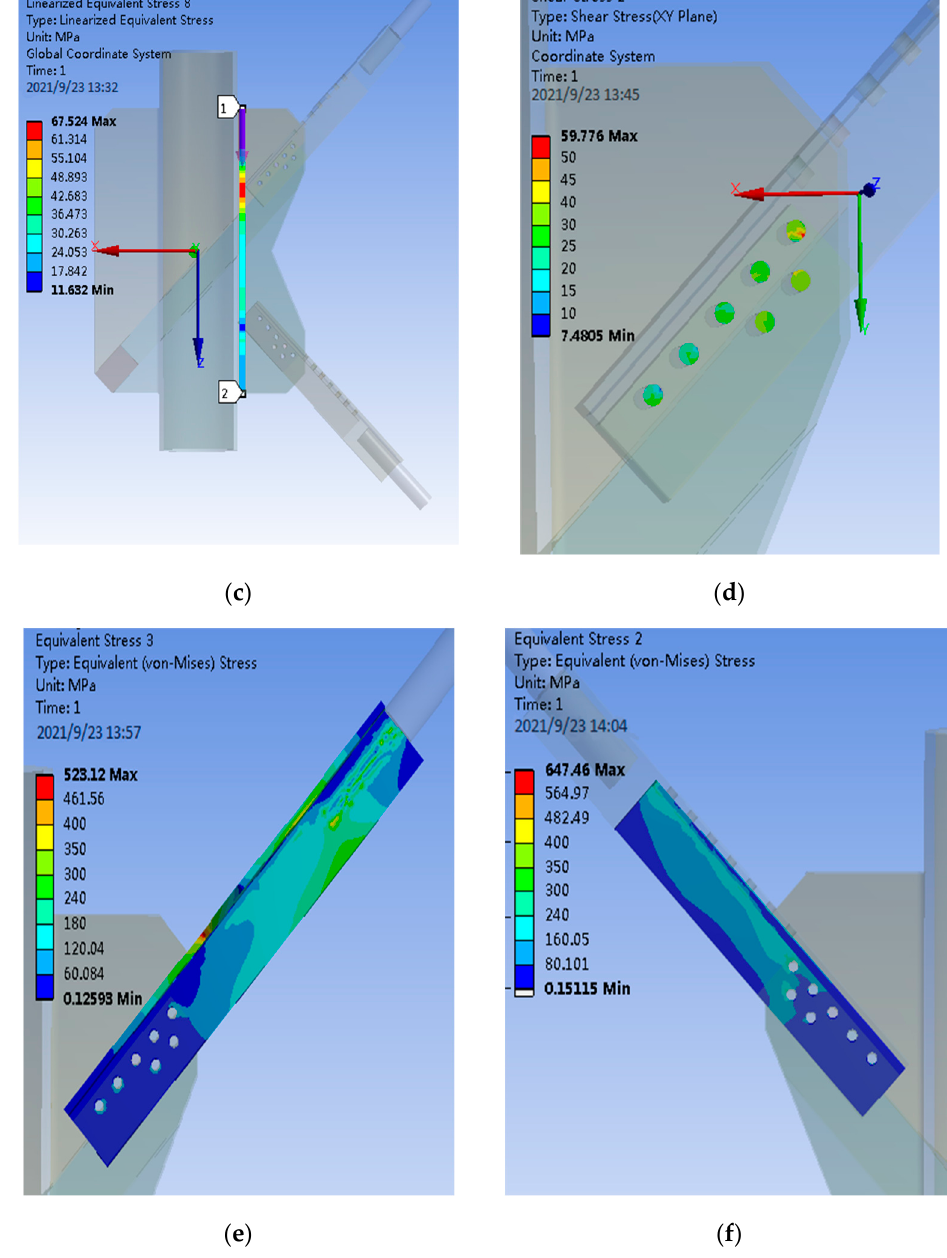
Figure 16. ( a ) Overall stress distribution of PDLDPJ; ( b ) stress distribution of the first path in the weld direction; ( c ) stress distribution of the second path in the weld direction; ( d ) stress distribution of connecting bolt of PDLDPJ; ( e ) stress distribution of long angle steel of PDLDPJ; ( f ) stress distribution of short angle steel of PDLDPJ.